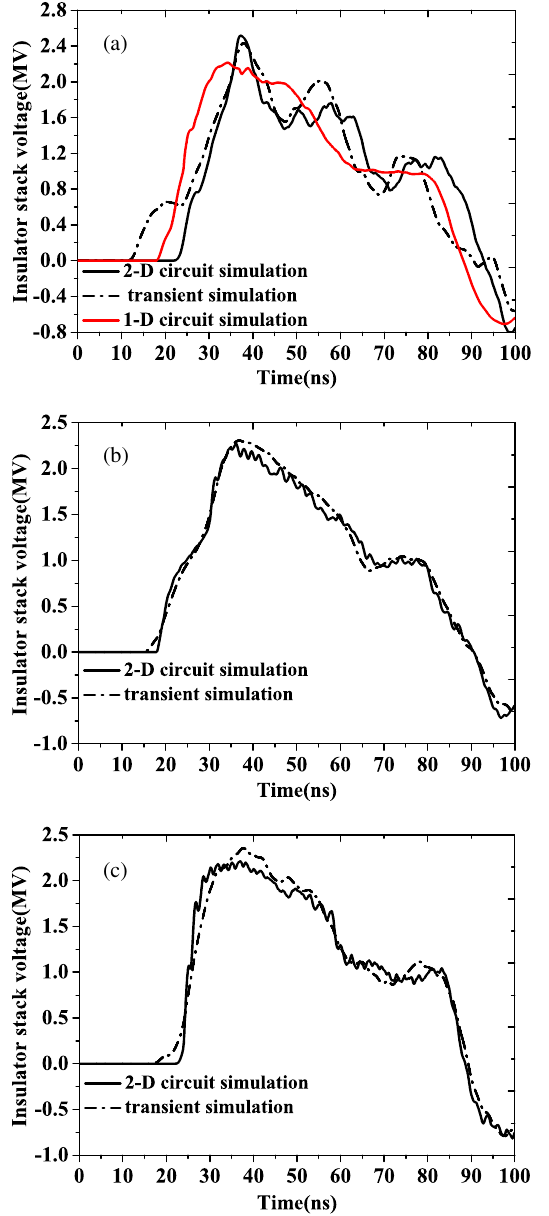
FIG. 7. Insulator stack voltage waveforms obtained by the two different methods at (a) 0 degree, (b) 90 degrees and (c) 180 degrees. The black solid line represents the results acquired by 2D circuit simulation. The black dash-dotted line represents the results acquired by transient electromagnetic simulation. The red solid line represents the result given by 1D circuit simulation. The consistency between the 2D circuit simulation results and transient electromagnetic simulation re- sults proves the exactness of this circuit model.